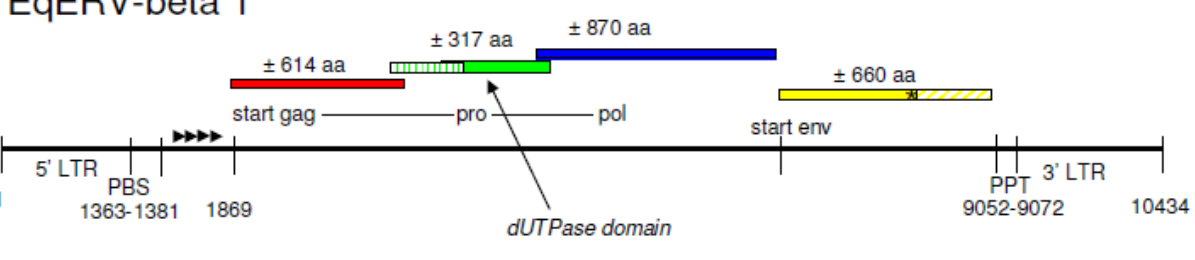
Figure 1. Schematic representation of the genome organization of the horse endogenous retrovirus EqERV-beta1 on chromosome 5. The figure is not drawn to scale, but important features and reading frames are indicated. A stopcodon in env is marked with an asterisk. The length of the provirus is 10434 nt. Four direct repeats located between the PBS and the startcodon of gag-pro-pol are indicated by arrowheads. LTR = long terminal repeat; PBS = primer binding site; PPT = polypurine